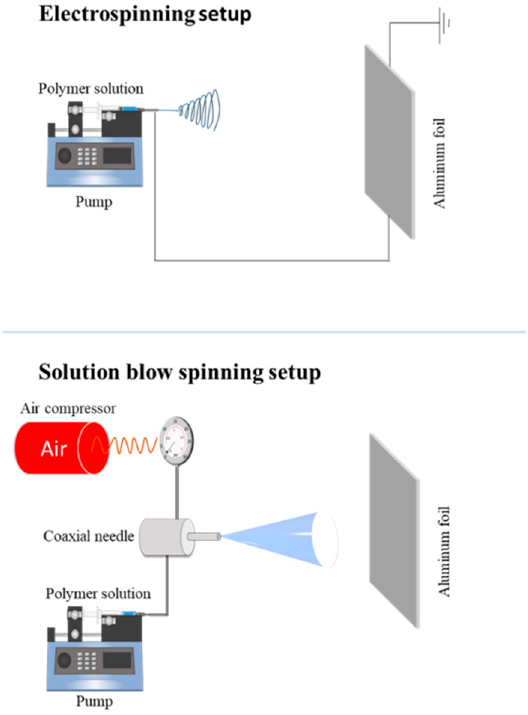
Figure 12. Electrospinning and solution blow spinning setup. Table 4. Sample code name and formulations of the relative solutions.